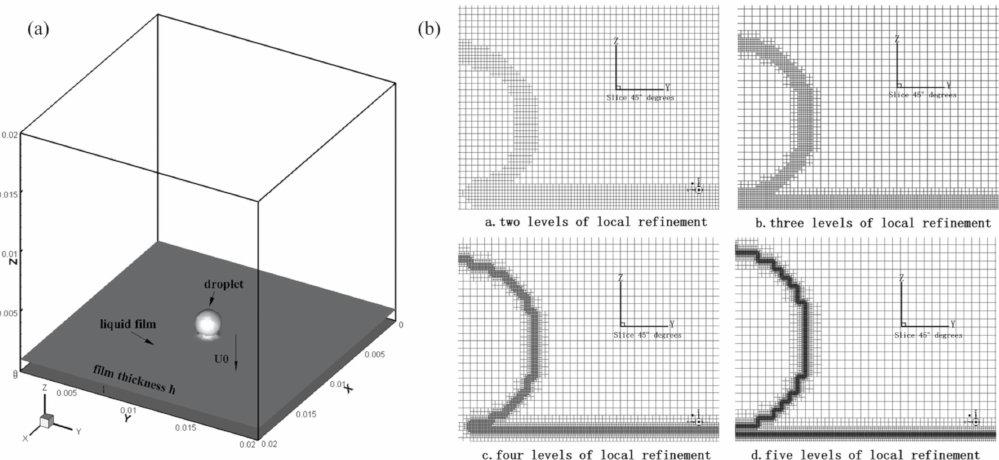
Figure 1. ( a ) The computational domain; ( b ) different levels of the adaptive grid in X = 0.01 m